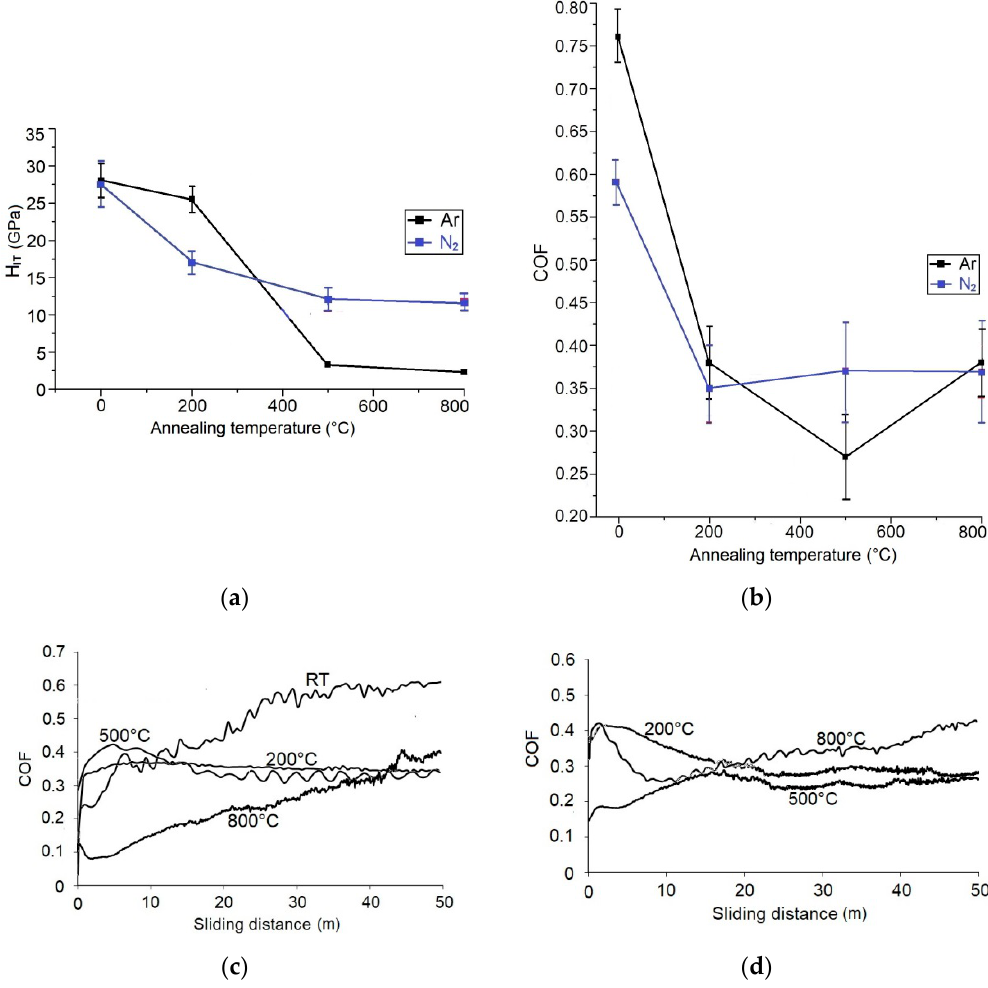
Figure 8. Dependence of H IT ( a ) and COF ( b ) vs. annealing temperature of the WC / C coatings deposited by using Ar or N 2 ; COF curves vs. annealing temperature of the WC / C coatings deposited by using N 2 ( c ) or Ar ( d ).